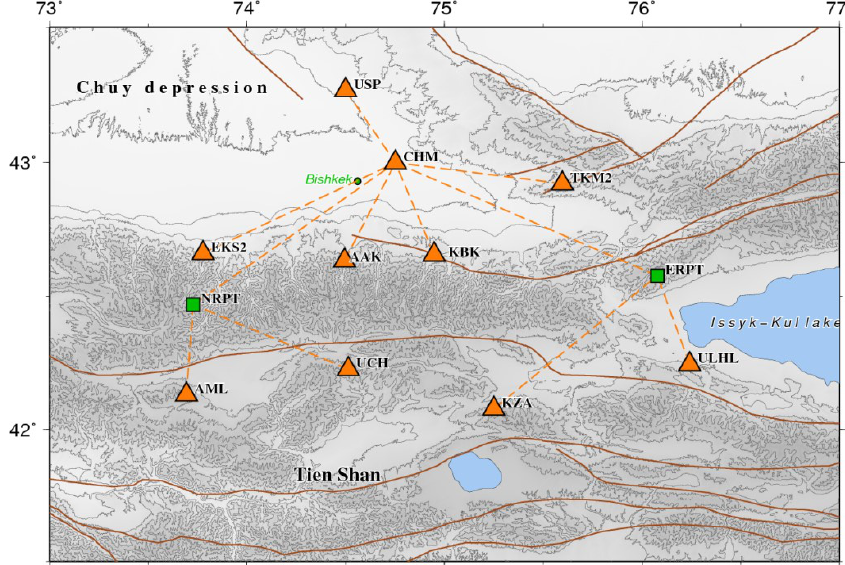
Fig. 1. Position of KNET network stations (triangles) and repeaters